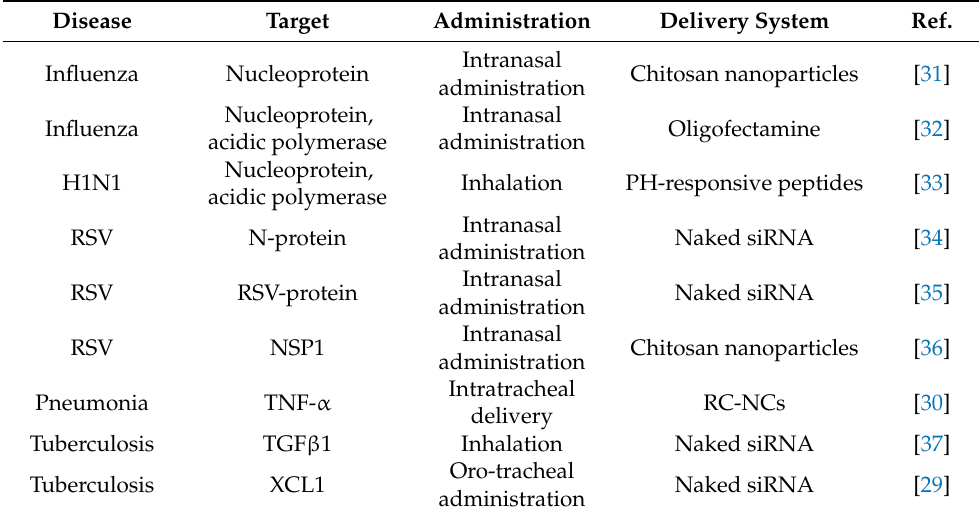
Table 2. Research of inhaled siRNA formulations for respiratory infections. Disease